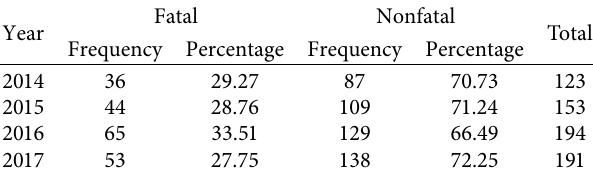
Table 1: Frequency distribution of crash injury severity